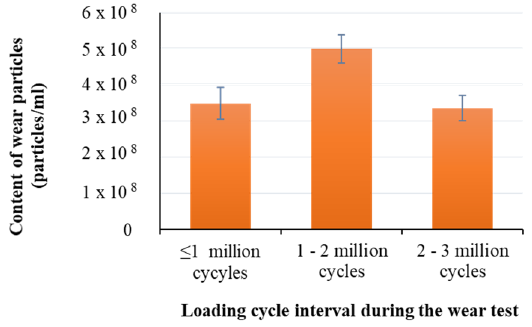
Figure 3. Content of wear particles generated after every one million cycles. The size of the wear particles was determined using the equivalent circular diameter (ECD). The results of Shapiro-Wilk test showed that the data of ECD was non-normally distributed. There was a significant difference in the size of the wear particles at the three test stages (one million, two million, and three million loading cycles) ( p < 0.001) (Figure 4). Moreover, the wear particles became large in size as the load cycles increased, giving a median ECD of 0.15 μ m (min: 0.14 μ m; max: 0.38 μ m) at one million cycles, 0.16 μ m (min: 0.15 μ m; max: 0.88 μ m) at two million cycles, and 0.17 μ m (min: 0.01 μ m; max: 0.89 μ m) at three million cycles (Figure 4). When summarized the size of wear particles into three intervals (0.10 μ m–0.19 μ m; 0.20 μ m–0.49 μ m; > 0.50 μ m), it found that the particles within 0.20 μ m in size covered 92.04% ± 2.60% of research particles at one million cycles, 79.58% ± 1.87% at two million cycles, and 51.32% ± 1.86% at three million cycles (Figure 5). Additionally, the distribution of the particles with the ECD less than 0.5 μ m after three million cycles reached 96.66% ± 0.77%. Figure 4. Size of wear particles measured by equivalent circular diameter (ECD). (*: p < 0.05) Figure 5. Distribution of wear particle size for each size interval.